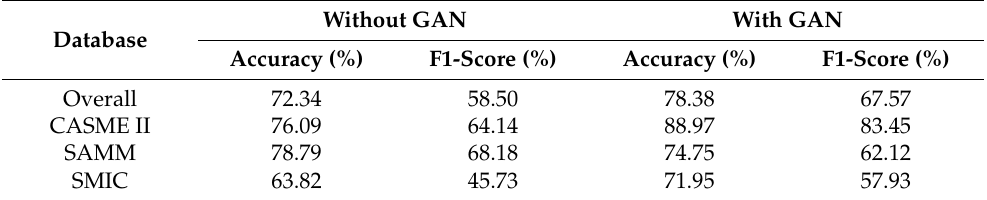
Table 5. ME recognition performance of modified VGGM with and without augmented training